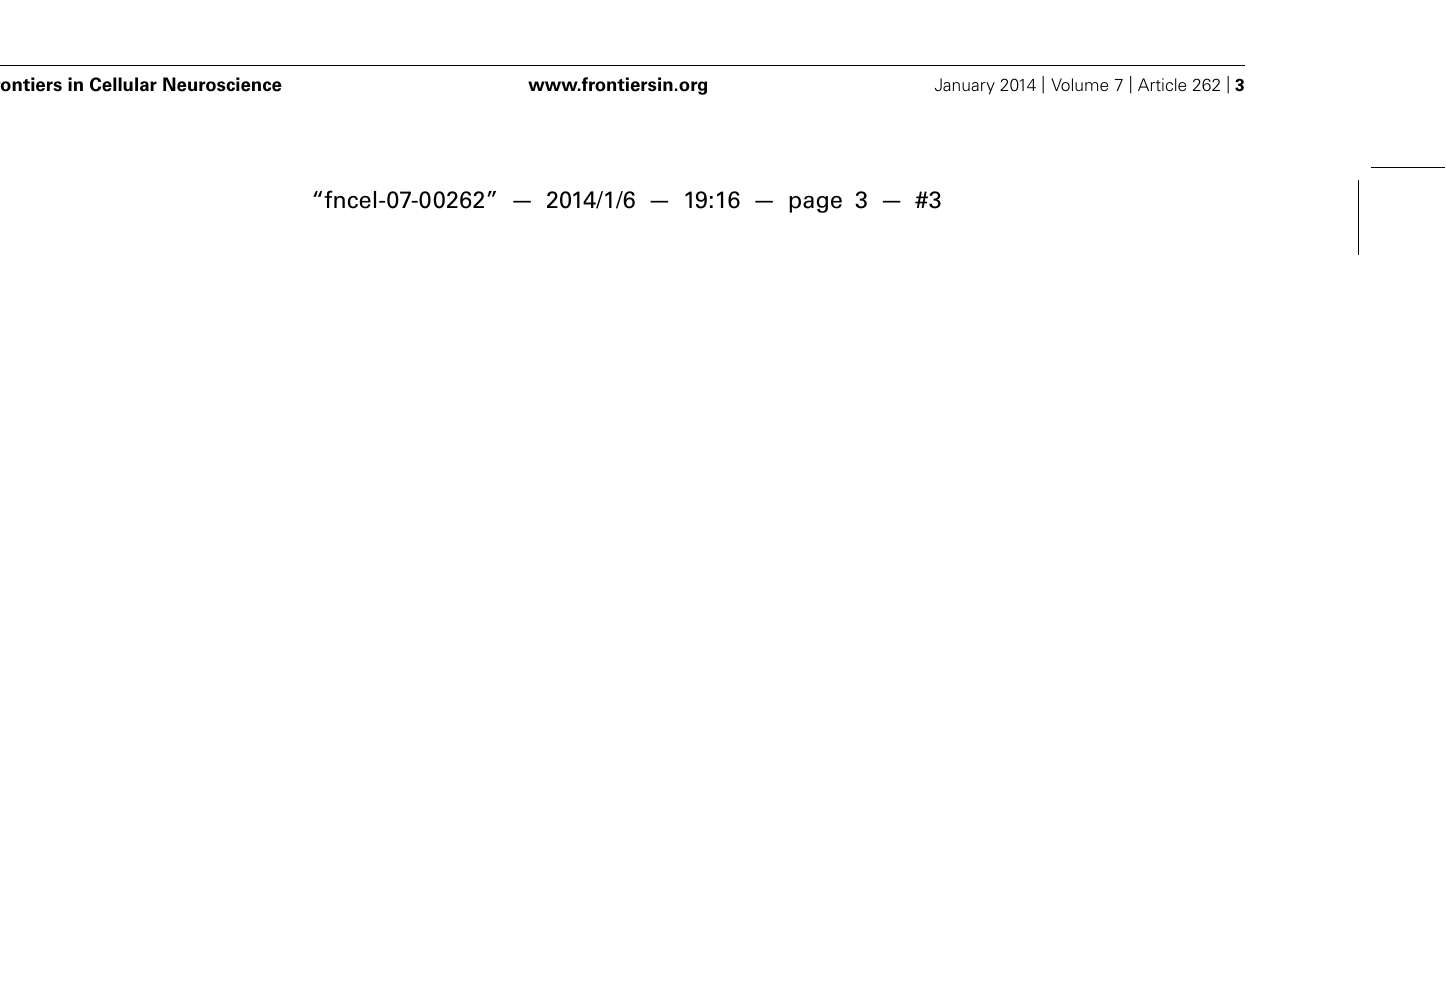
FIGURE 2 |Anatomy and Ca handling at recurrent synapses between CA3 pyramidal cells. (A) Electron microscopy of a recurrent terminal, b2, apposed to a CA3 pyramidal cell dendritic spine, s2. (B) Three-dimensional reconstruction of the contact.The area of the active zone [arrows in (A) ] was 0.10 μ m 2 . (C) Double immuno-staining of SDS-digested freeze fracture replica of a recurrent synapse.The smaller gold particles label Cav2.1